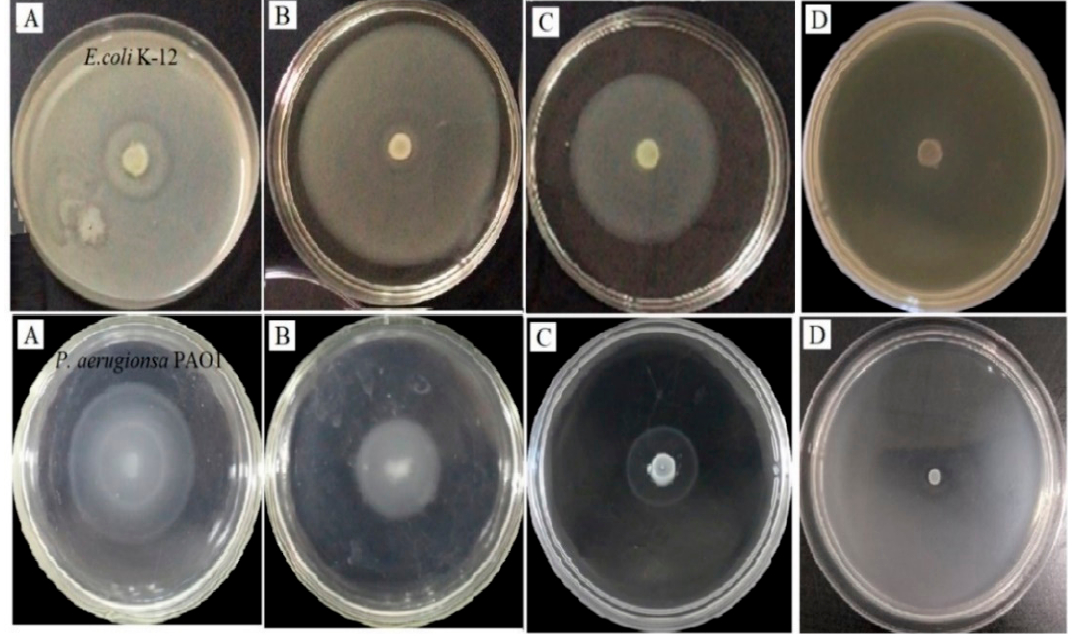
Figure 3. CFEE a ff ected on migration distance of E. coli K-12 and P. aerugionsa PAO1: ( A ), CK; Figure 3. CFEE affected on migration distance of E. coli K-12 and P. aerugionsa PAO1: A , CK; B , 50 ( B ), 50 µ g / mL of CFEE; ( C ), 100 µ g / mL of CFEE; ( D ), 200 µ g / mL of μ g/mL of CFEE; C , 100 μ g/mL of CFEE; D , 200 μ g/mL of CFEE.